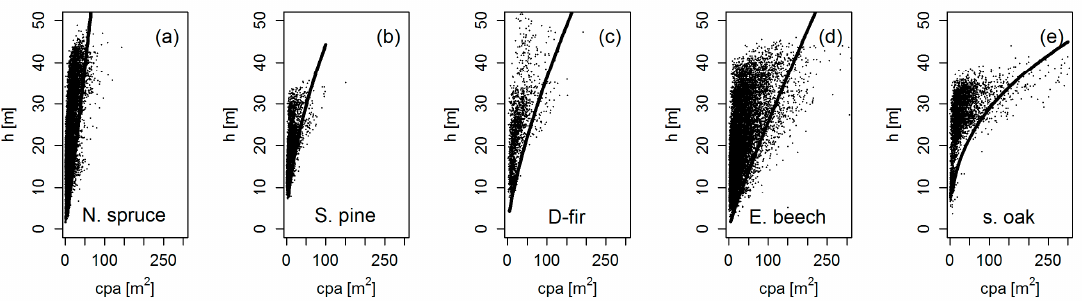
Figure 5. Species-specific development of crown projection area with increasing tree height for five primary tree species in Europe. Data from long-term experimental plots in South Germany. The black line indicates the 95% quantile of the cpa-h relationship (see model 1 in Table 1).